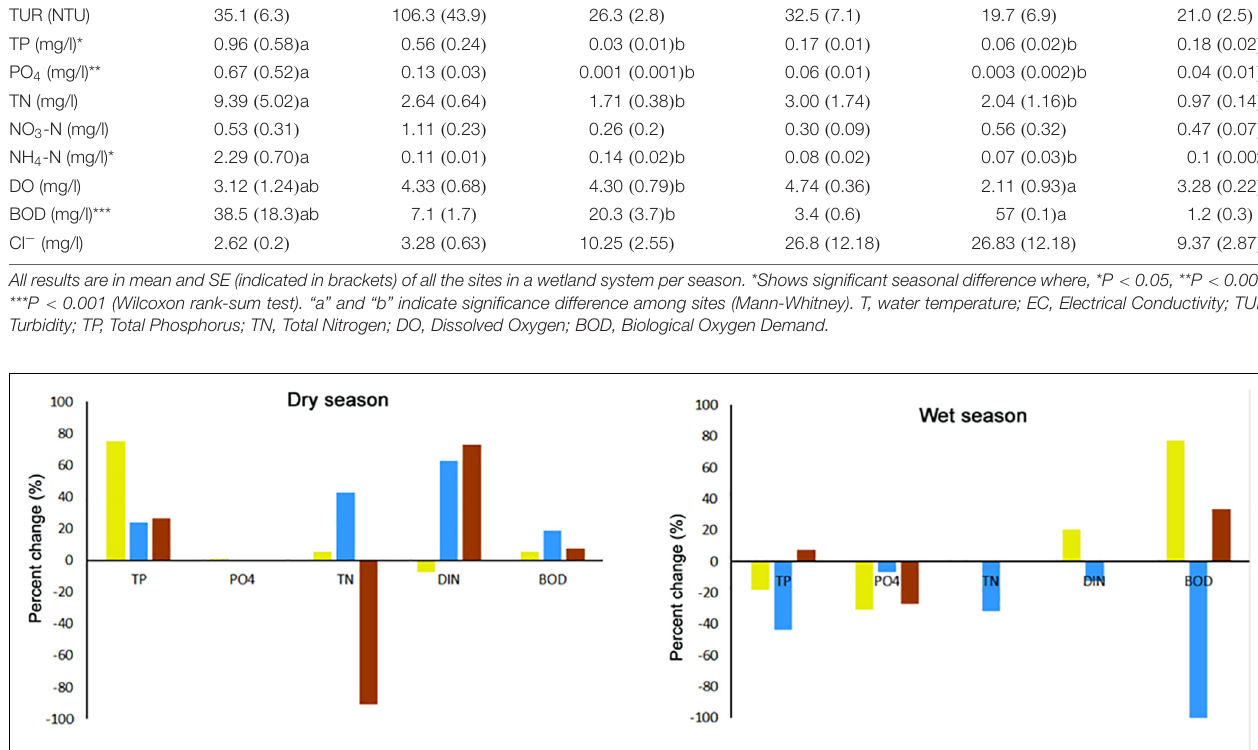
77%, followed by Kitto wetland; 33% ( Figure 2 wet season and Supplementary Table S3